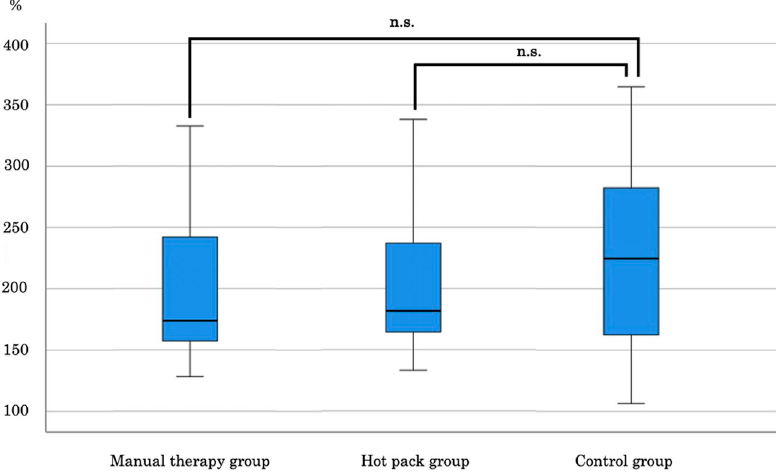
Fig 2. Comparison of the data between the manual therapy, hot pack, and control groups after the intervention. IPFP, infrapatellar fat pad; n.s., not significant.